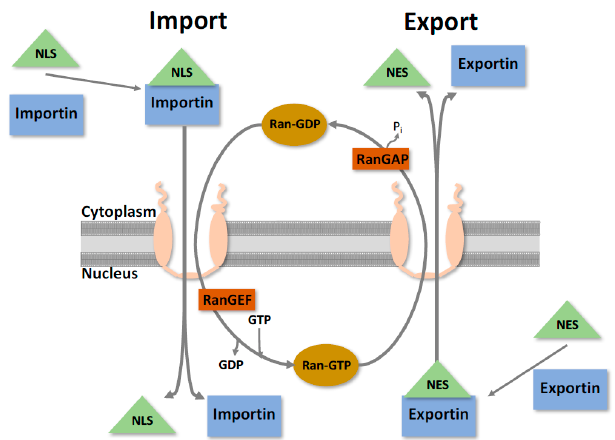
Figure 2. Simplified nucleocytoplasmic protein transport. The nuclear envelope is the physical barrier between the nucleus and the cytoplasm, and is studded with channels known as nuclear pore complexes. For proteins to undergo nucleocytoplasmic transport, they require a nuclear localisation sequence (NLS) or nuclear export sequence (NES), and its corresponding karyopherin. Transport then occurs through the nuclear pore, with directionality determined through interactions with the Ran cycle. When in the cytoplasm, Ran is in a GDP bound state and can facilitate nuclear import. Once in the nucleus, the GDP gets converted to GTP and now can facilitate export [9].